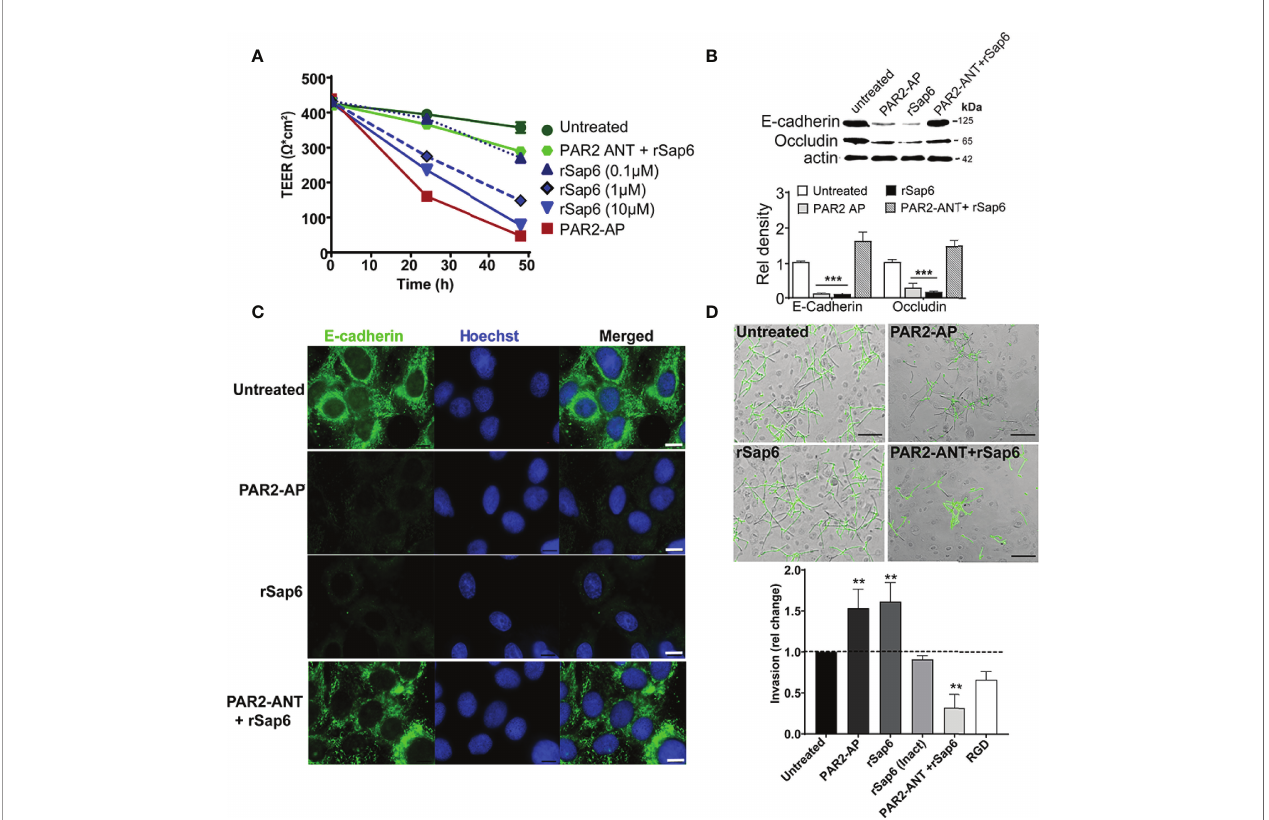
FIGURE 6 | Sap6 mediated PAR2 activation results in decreased epithelial barrier integrity and increases C. albicans invasion. (A) Changes in TEER value in OECs treated with rSap6 (0.1-10µM), PAR2-ANT+rSap6 and PAR2-AP were calculated over 48 h using an EVOM2 epithelial volt ohmmeter. Measured TEER values were normalized to untreated OECs. There was a dose dependent reduction of TEER value in OECs treated with rSap6 (0.1-10µM) with 10 m M rSap6 causing a 78% reduction in TEER similar to PAR2-AP treated cells. OECs pre-treated with PAR2-ANT before Sap6 treatment did not show any signi fi cant change in TEER. (B) OEC levels of E-cadherin and occludin proteins were examined by immunoblot and densitometry following 24 h treatment of cells with PAR2-AP, rSap6 or PAR2-ANT +rSap6 using E-cadherin or occludin antibodies. OEC treated with either rSap6 or PAR2-AP showed signi fi cant reduced levels of both E-cadherin and occludin compared to OEC control, while pretreatment with PAR2-ANT before Sap6 restored levels of both E-cadherin and occludin to control. Signi fi cance was calculated using two-way ANOV compared to untreated OECs. P values are p ≤ 0.01 (**), p ≤ 0.001 (***). (C) Cell surface expression of E-cadherin was visualized microscopically following rSap6 or PAR2-AP treatment, then OECs were fi xed, permeabilized and stained with E-cadherin (green) and Hoestch (blue). Untreated OECs showed high expression of surface E-cadherin, whereas treatment with rSap6 or PAR2-AP reduced E-cadherin expression that was blocked by pretreatment with PAR2-ANT. Scale bar indicates 10 m m. (D) Candida albicans cells (1 × 10 5 ) were added to OEC monolayers pretreated with PAR2-AP, rSap6, RGD+rSap6 or PAR2-ANT+rSap6. After 4.5 h, epithelial cells were permeabilized and C albicans cells were stained with anti-Candida antibody and Alexa Fluor 488 to visualize non- invading cells (green). Invasion was quantitated as percentage fold change in invasion comparing to untreated OECs. OECs treated with rSap6 or PAR2-AP had higher invasion while rSap6 (Inact) did not change invasion levels of C albicans . Pre-treatment of OECs with PAR2-ANT or RGD+rSap6 resulted in reduced hyphal invasion. Scale bar indicates 20